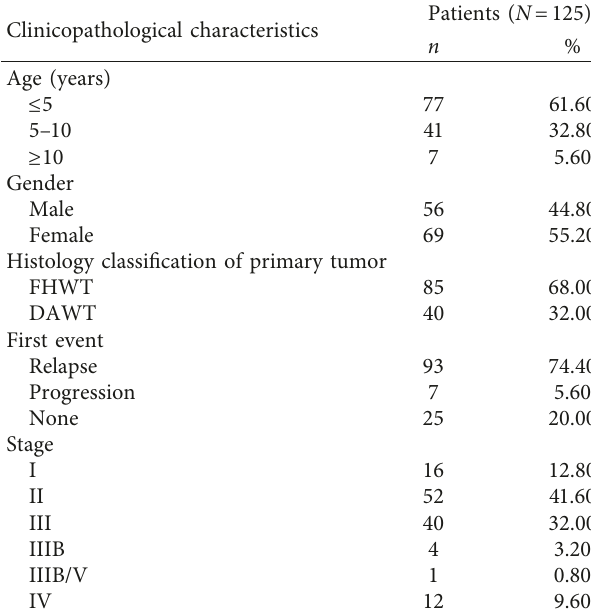
Table 1: The main characteristics of 125 Wilms tumor